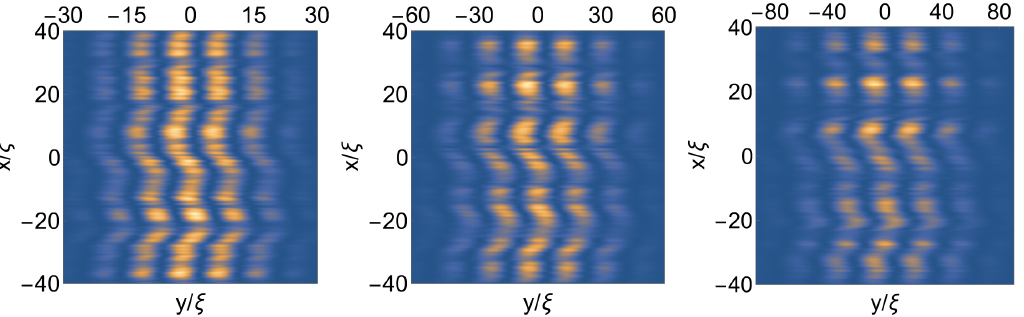
( x , (cid:126) r , t + t ) , using Figure 5: Outcomes for a single projective measurement of ˆ ρ tof 1 0 (29), observed for different time-of-flight values t and at fixed one-dimensional 1 = 14 ξ/ v . The temperature in the symmetric sector is 34nK, which evolution time t 0 T = 0.5 ħ h ω ⊥ , using the parameters from Section 5.3. From left corresponds to k B = 8,16 and 24ms, respectively. The underlying to right, the time of flight is t 1 eigenvalues e i ϕ a , s ( x , t 0 ) are taken to be identical in all three plots in order to accentuate the effects of the time of